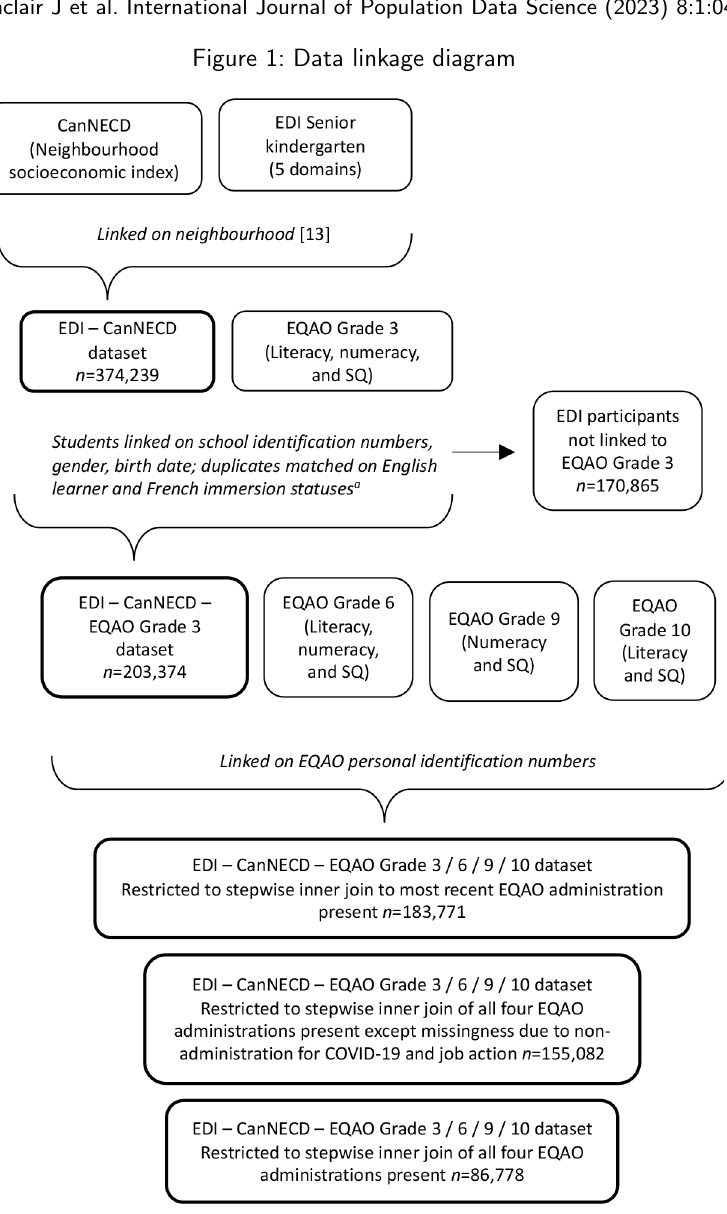
Figure 1: Data linkage